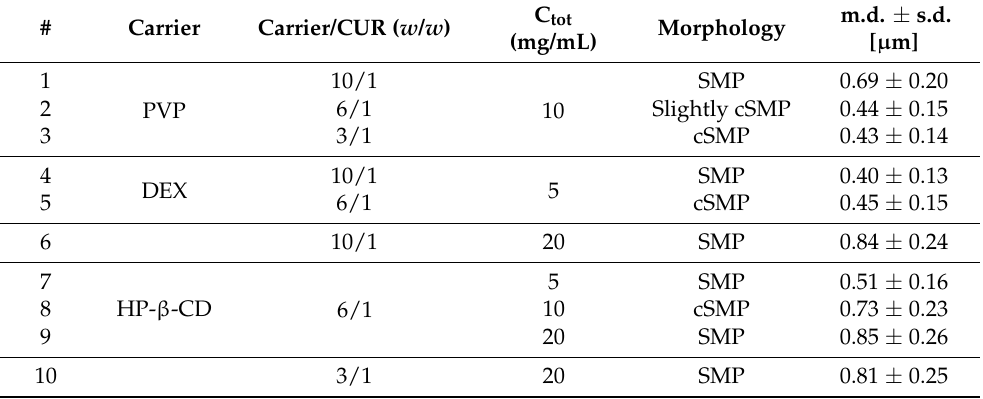
Table 3. A summary of SAA experiments conducted. SMP: sub-microparticles; cSMP: